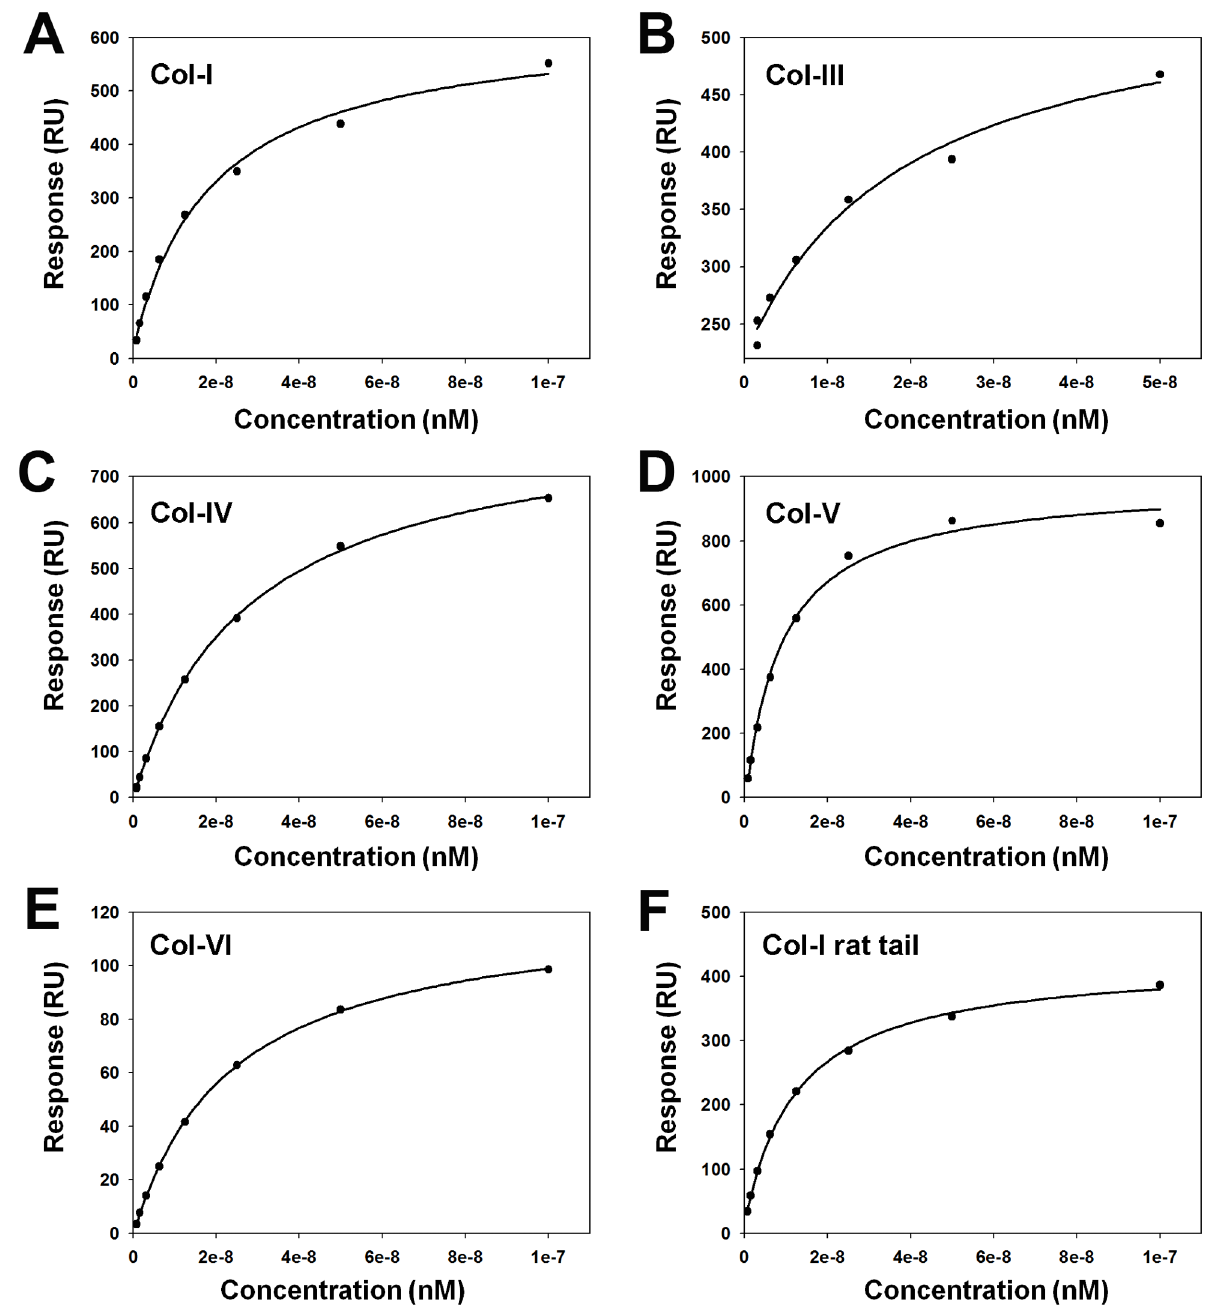
Figure 5. Affinity values for Simplagrin with different collagen types. (A-F) Soluble human collagen type I, III, IV, V, VI and rat tail I were flowed over immobilized Simplagrin. Fitting of steady-state responses from Simplagrin collagen interaction measured by surface plasmon resonance. The steady-state signal reached at the end of the analyte injection (240 seconds at 30 m L/minute) was plotted against the analyte concentration and the resulting curve fitted with a Langmuir 1:1 binding model. different temperatures (15, 20, 25, 30, 35, and 40 u C). The analysis of Simplagrin-collagen interaction shows that no confor- association (k a ) and dissociation (k d ) rate constants, as well as the mation change occurs during complex formation (Figure 6). affinity constant (K D ), were obtained and fitted to a linear form of the van’t Hoff equation to estimate the D H, D S, and D G (Figure 4C and D). Thermodynamic analysis of the Simplagrin- collagen interaction shows that this interaction is both entropically and enthalpically driven with a larger negative D G, indicating that this interaction is favorable and occurs spontaneously (3). CDS